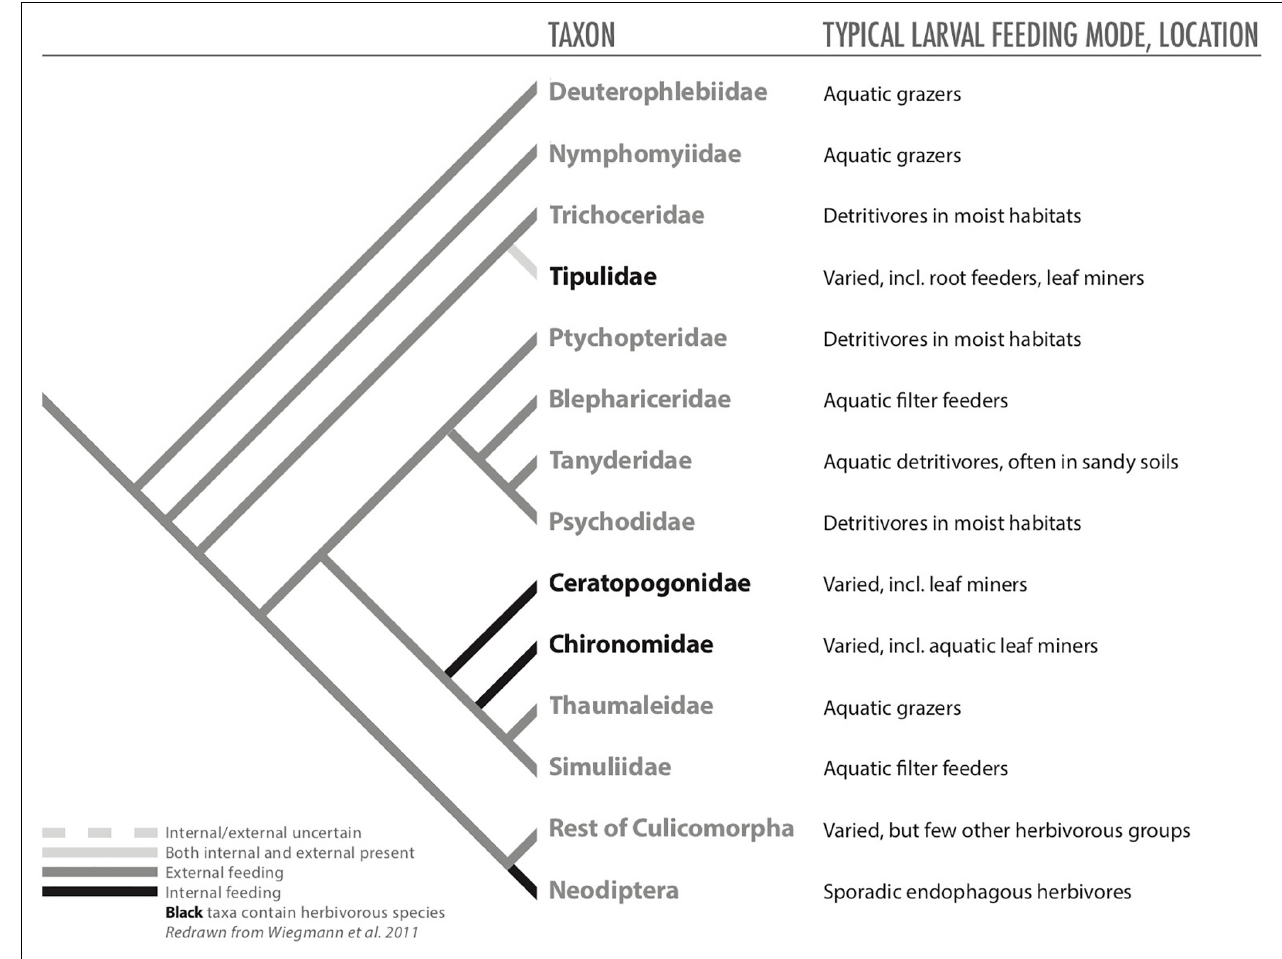
FIGURE 5 | Phylogeny of basal Diptera (from Wiegmann et al., 2011) redrawn to illustrate hypothesized distributions of internal and external feeding among